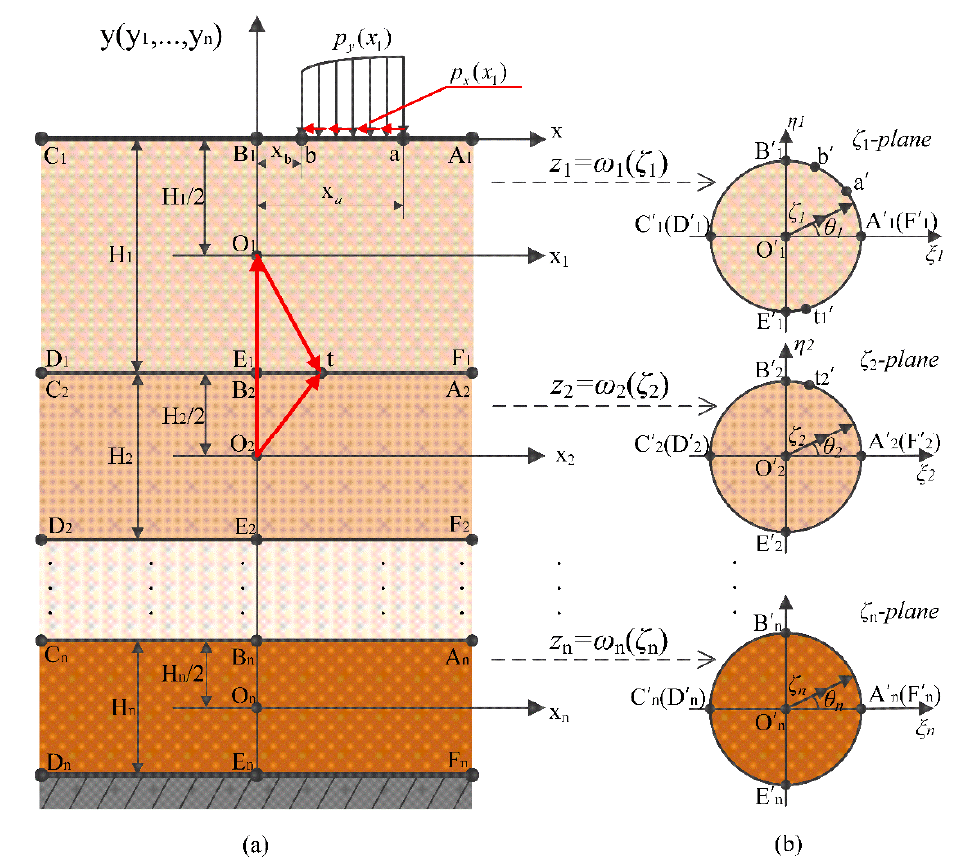
Figure 1. The multi-layer soil above the bedrock is mapped on to the inner domain of the unit circle in the image plane: ( a ) multi-layer soil subjected to strip load and ( b ) each layer is mapped to the inner domain of the unit circle in the image plane.